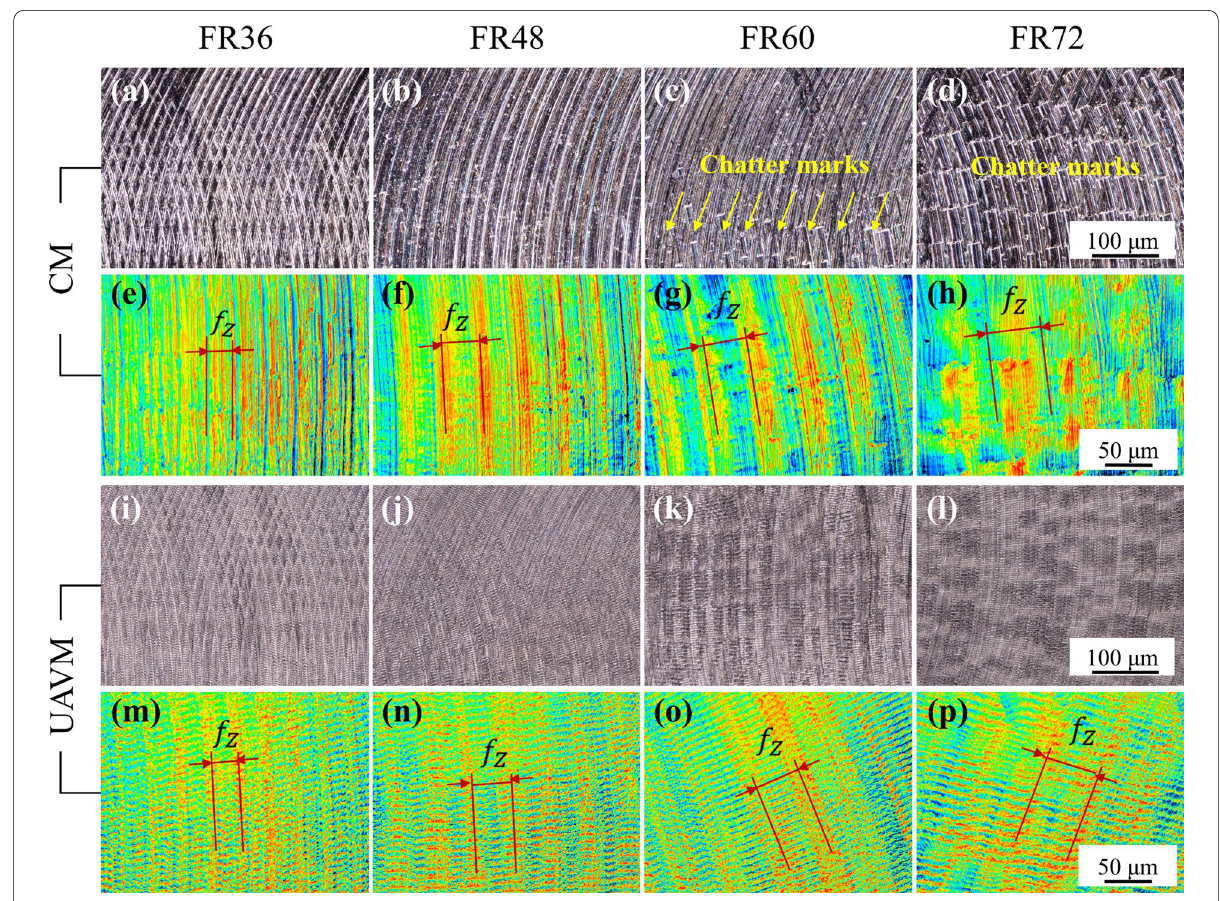
Figure 6 Surface topography of the workpieces machined under different conditions (FR means feed